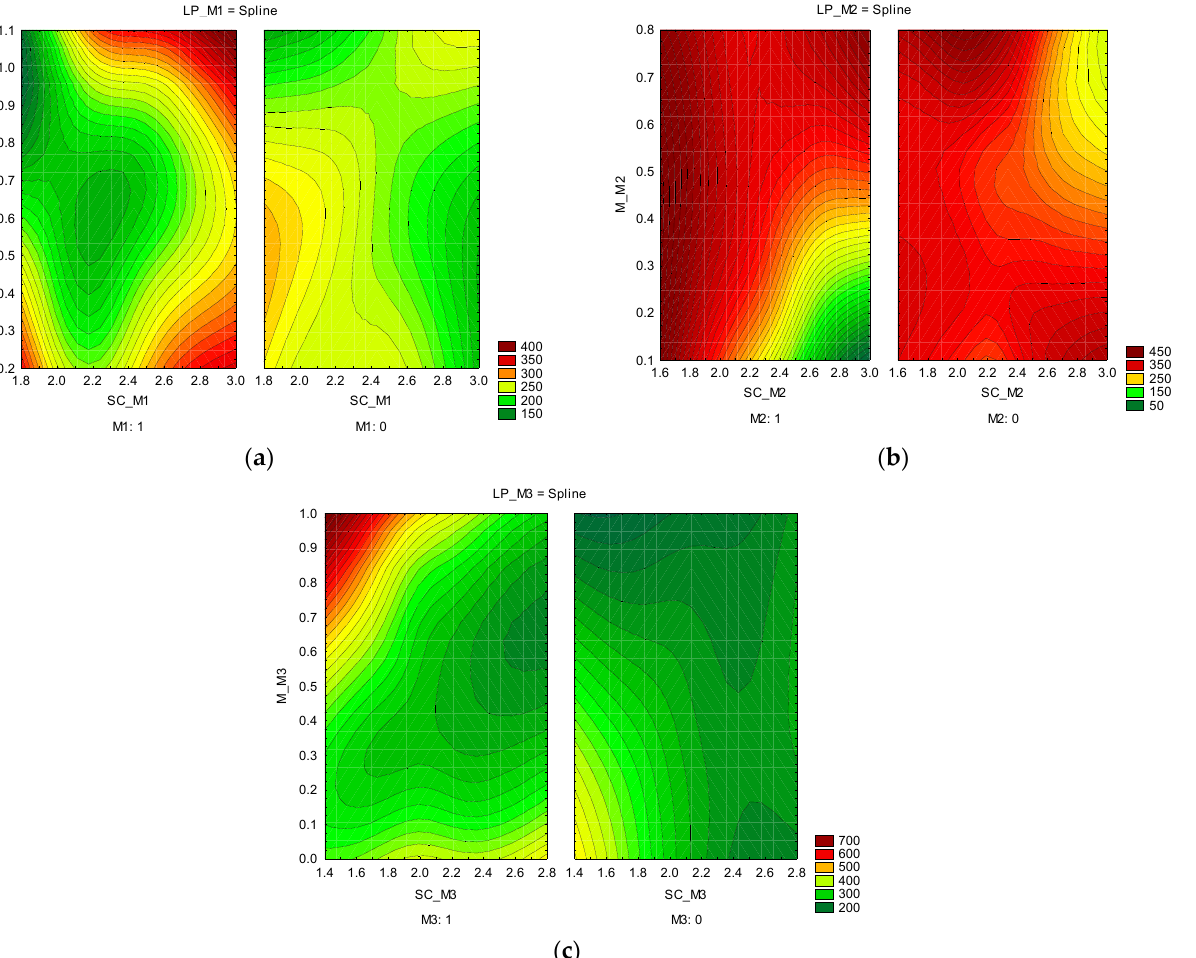
Figure 4. 3d-maps of the dependence of labor productivity (LP) on social capital (SC) and motiva- tion (M): ( a ) under the program M1 implementation, for the treatment group (M1:1) and the con- trol group (M1:0); ( b ) under the program M2 implementation, for the treatment group (M2:1) and the control group (M2:0); ( c ) under the program M3 implementation of the activity M3, for the treatment group (M3:1) and the control group (M3:0).